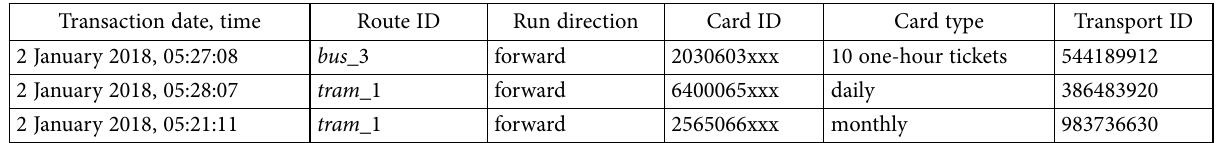
Table 2. Example validation records